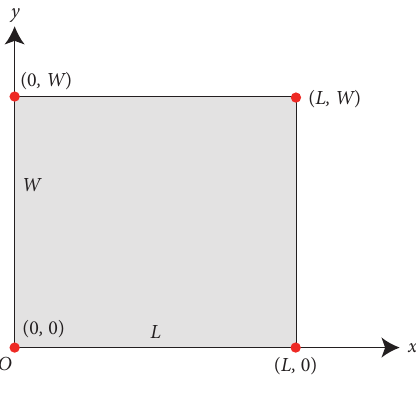
Figure 9: The electrode unit